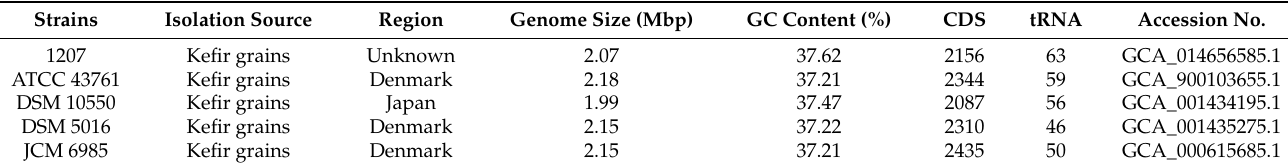
Table 1. Genome information for nine L. kefiranofaciens strains as published by